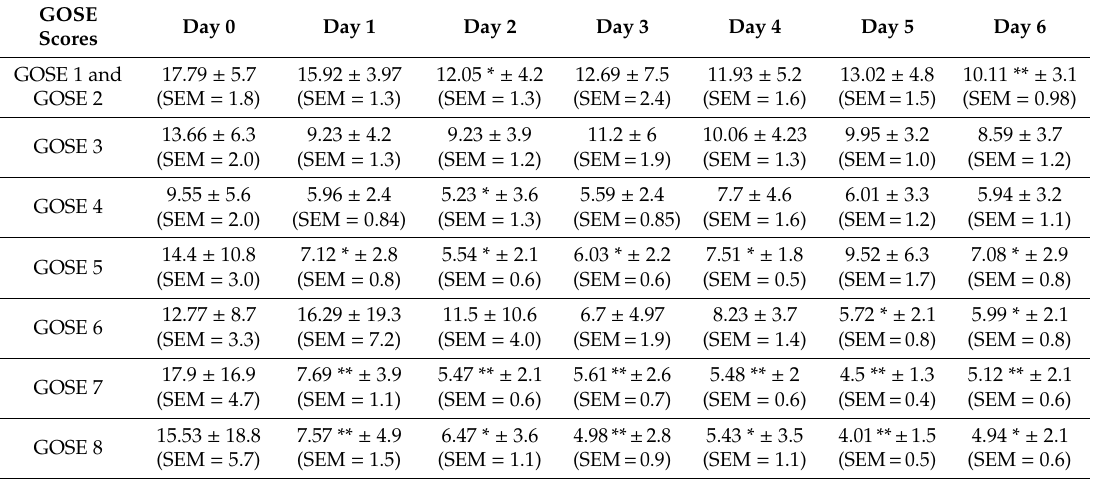
Table 3. Changes in the mean value of neutrophil-to-lymphocyte count ratio (NLCR) during the first 6 days of treatment in accordance with 6-months Extended Glasgow Outcome Score (GOSE). * p < 0.05, ** p < 0.01—comparison with admission day (Day 0).